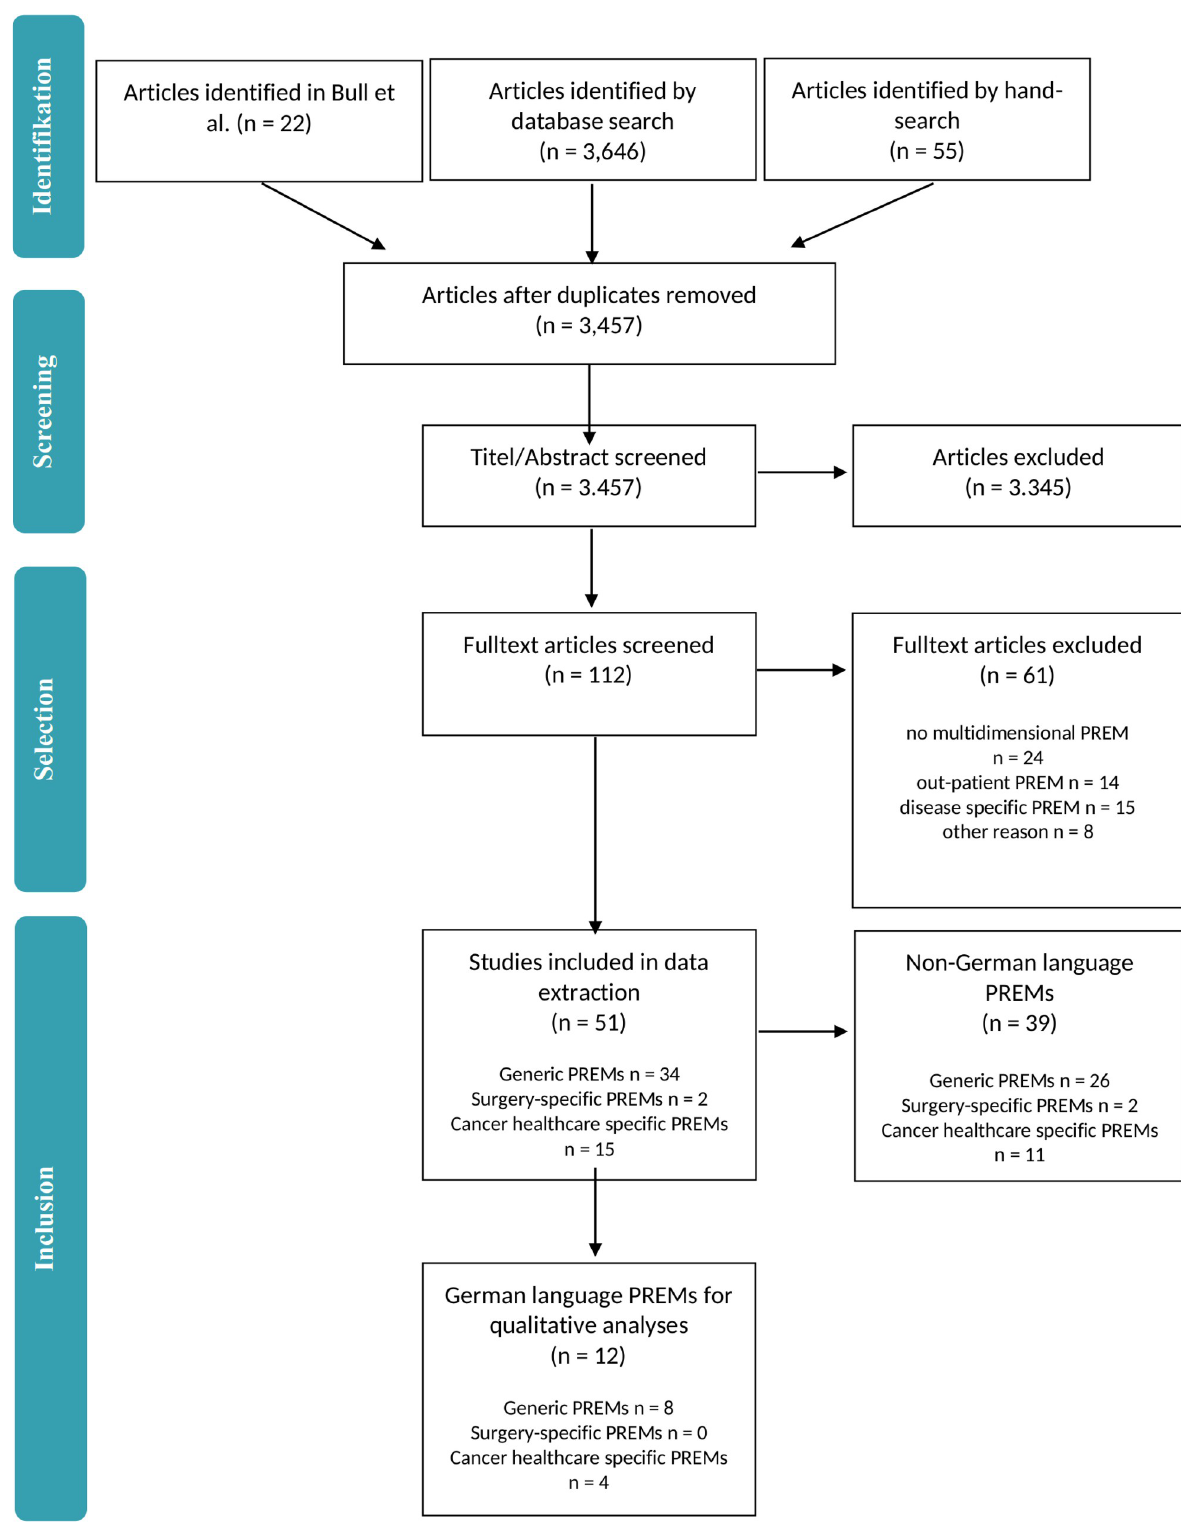
Fig 1. PRISMA Flow-chart of included studies.